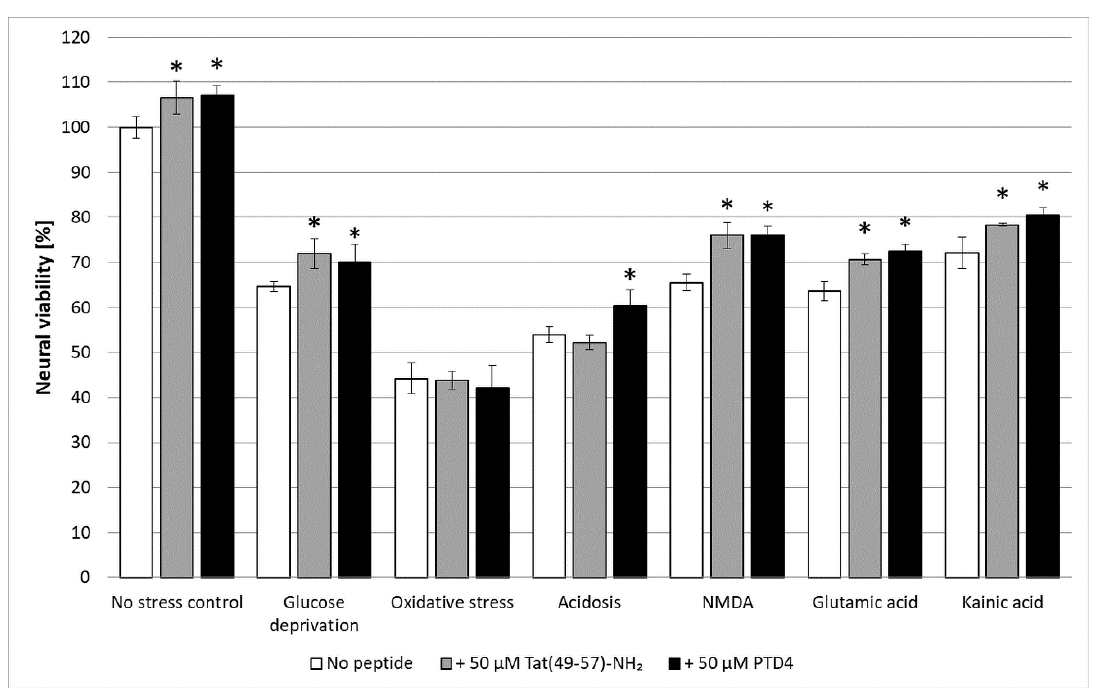
Figure 7. Pro-viable activity of Tat(49–57)-NH 2 and PTD4 peptides in a multifactorial in vitro model of AIS. Non-insulted cells were treated as 100% control. Two-way ANOVA statistics: n = 3; * p < 0.05. Each statistical significance asterisk refers to a respective no-peptide control (white bar) ± SD.